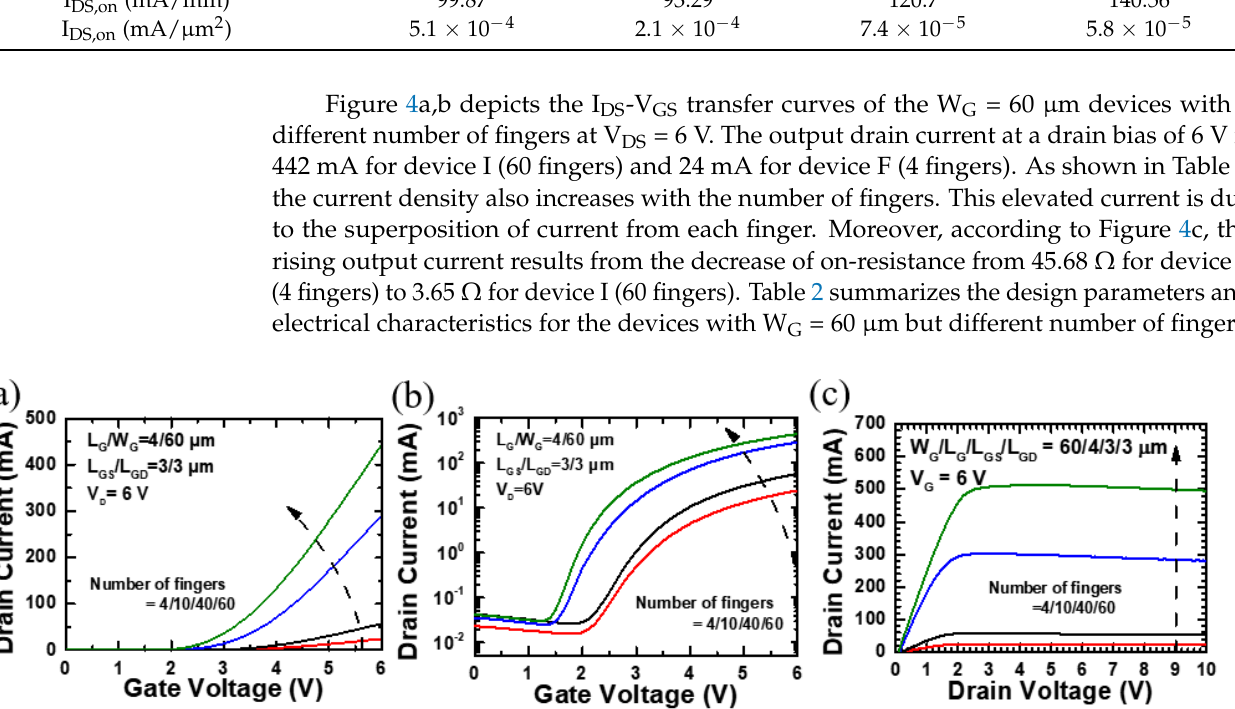
Figure 4. Device performance of p-GaN HEMTs (W G = 60 μ m) with different number of fingers (4/10/40/60) at V DS = 6 V: